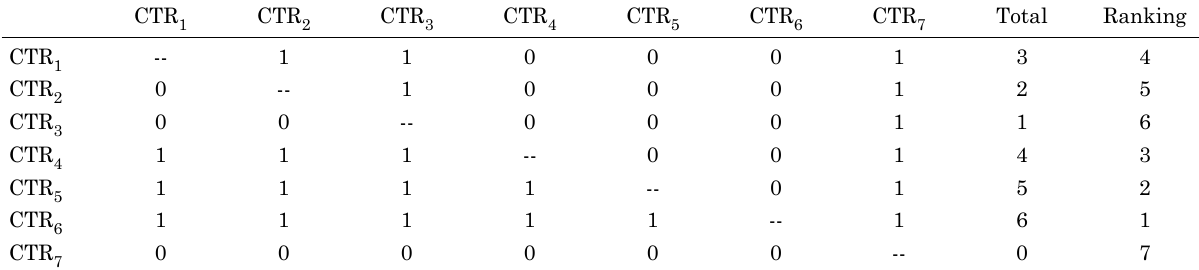
Table 2. Matrix of overall preferences